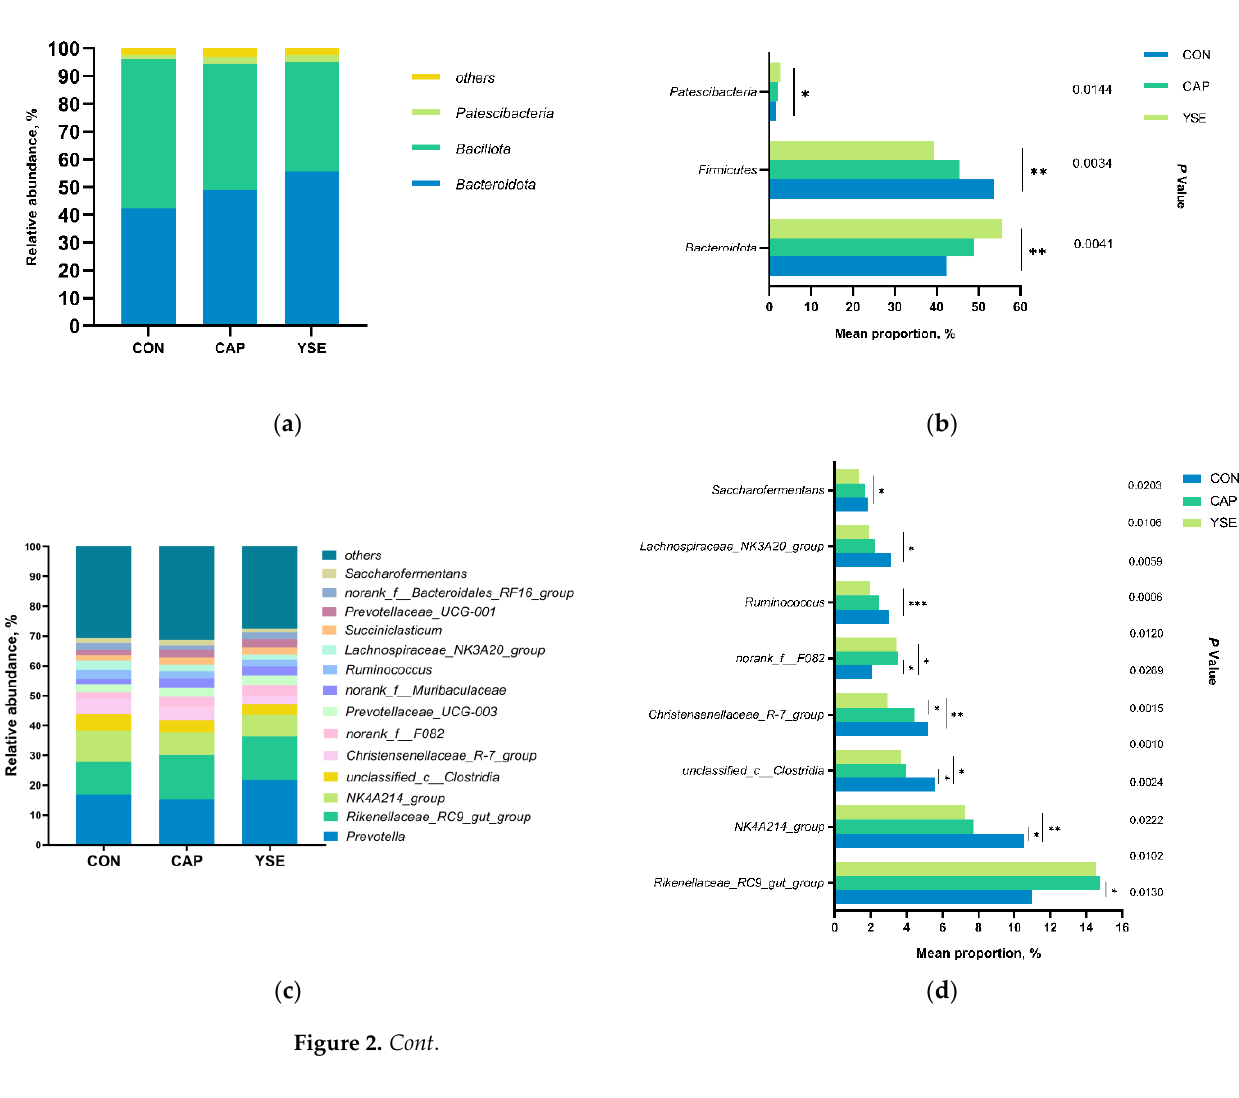
( f ) Figure 2. Relative abundance of rumen bacteria at ( a ) phylum and ( c ) genus levels in the 3 groups. Histogram of group difference test for rumen bacteria at ( b ) phylum and ( d ) genus levels. ( e ) LEfSe multilevel species hierarchy tree diagram; LDA > 3.5. ( f ) LDA discriminant result graph LDA > 3.5. CON: control group; CAP: capsaicin group; YSE: Yucca schidigera extract group. * 0.01 < p ≤ 0.05; ** 0.001 < p ≤ 0.01; *** p ≤ 0.001.